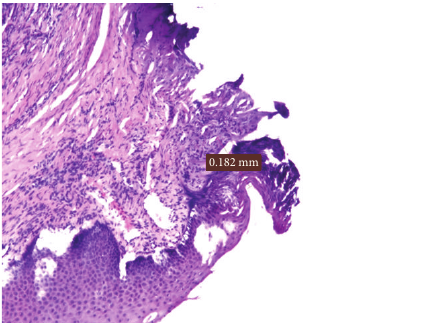
Figure 9: Damage measurement in a giant cells granuloma.